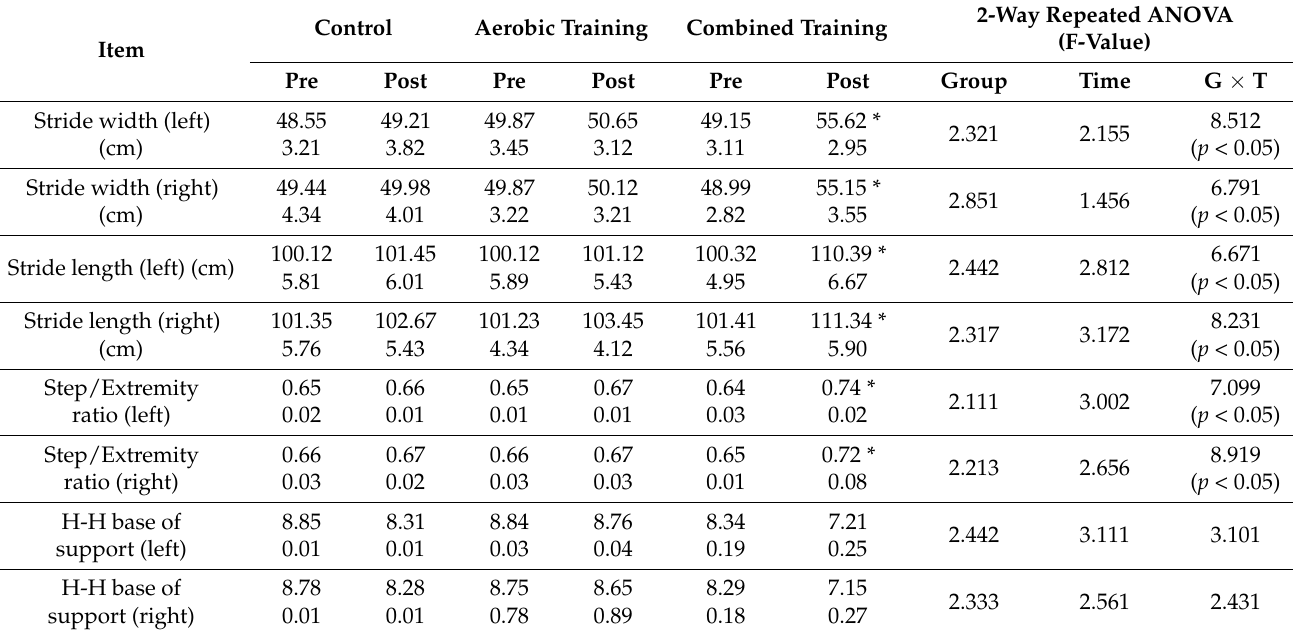
Table 4. Changes of spatial parameters of gait after 12 week exercise